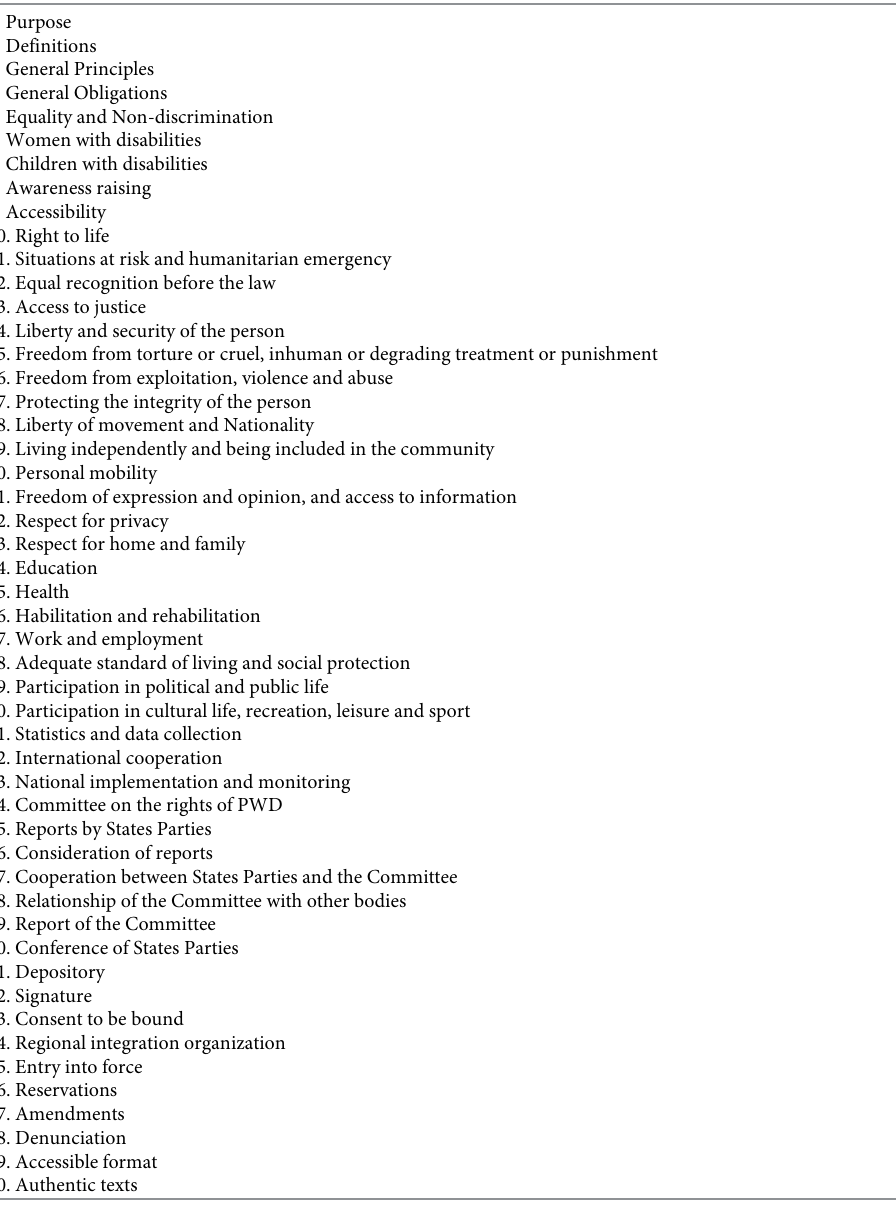
Table 1. Articles of the UN